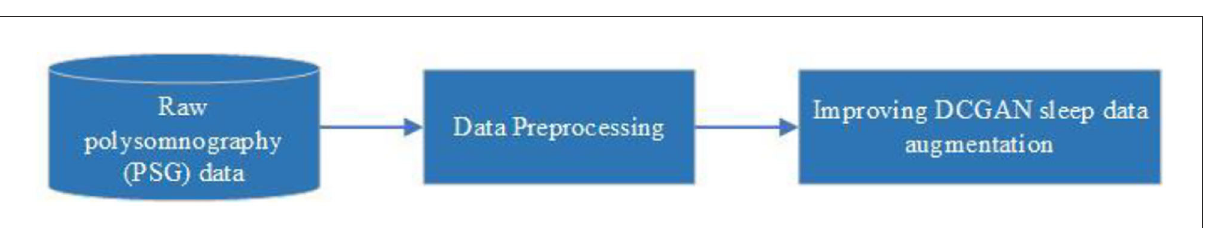
FIGURE7 Overall experimental